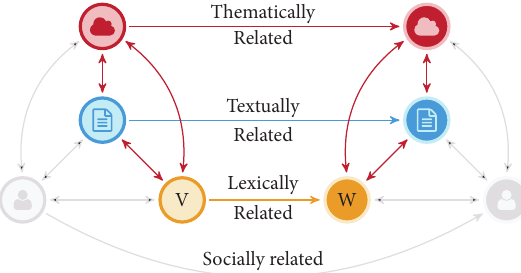
Figure 10: Schematic depiction of the informational sources of linking topics (red vertices) in word topic networks as a function of the textual relatedness of two texts (blue vertices) (that belong to of a corresponding LMN—see Definition 1) and the lexical layer L 1 relatedness of corresponding words (orange vertices) (that belong to layer L of a corresponding LMN). Bidirectional red arcs denote 3 arcs of the corresponding margin layers in Definition